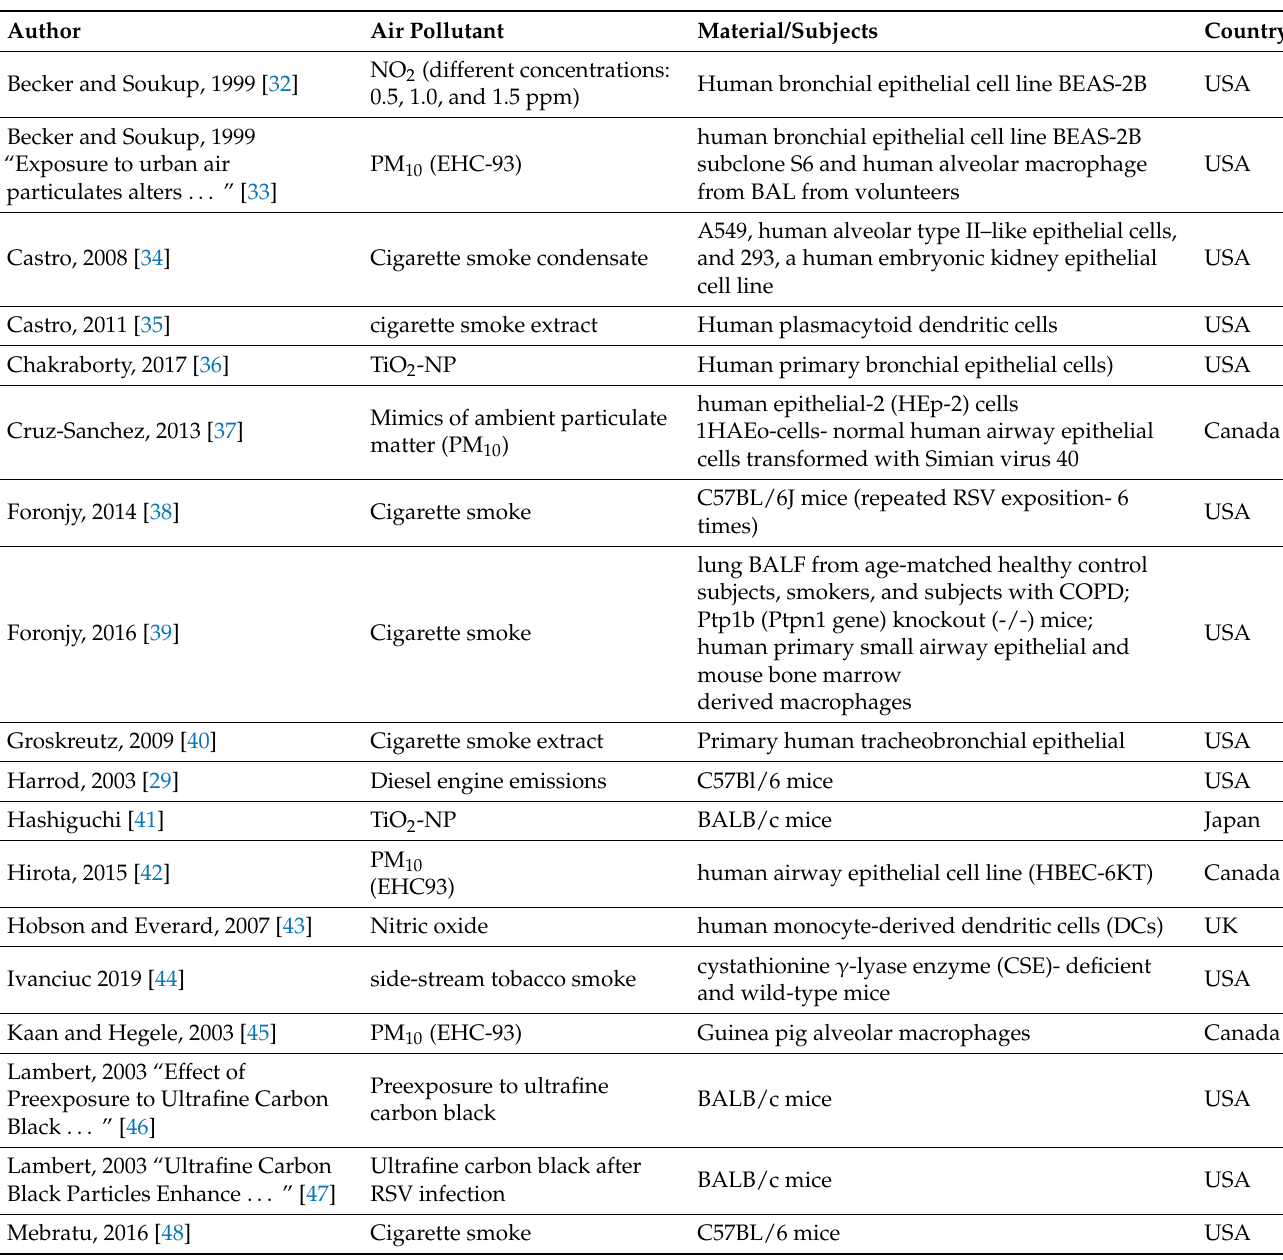
Table 2. Studies included in the scoping